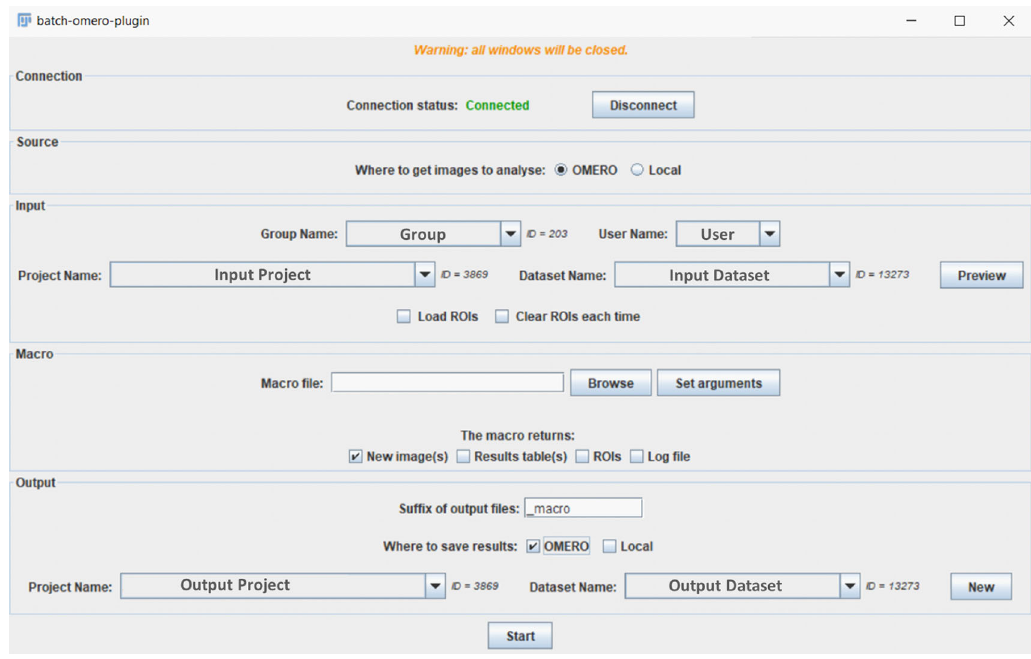
Figure 1. GUI window of the batch OMERO